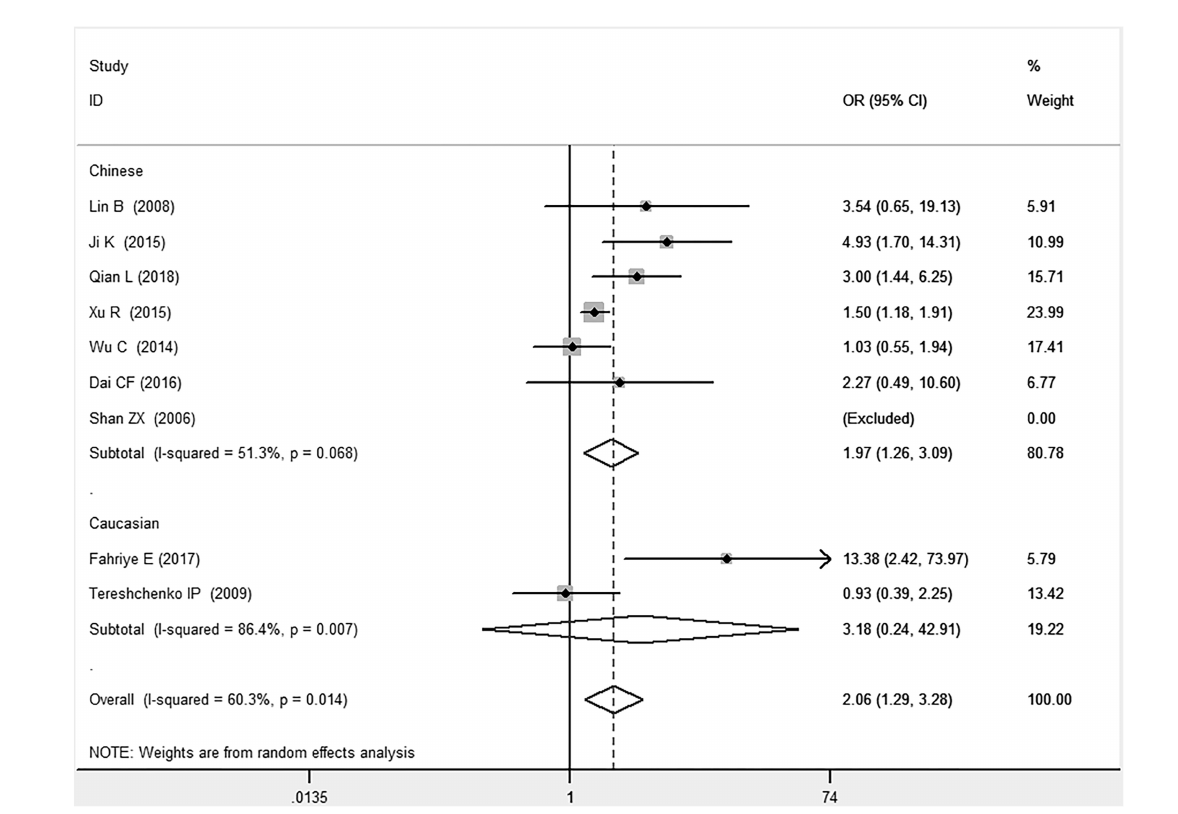
FIGURE5 Forest plot of CAD associated with MIF gene rs755622 G/C polymorphism under a homozygous genetic model (i.e., CC vs. GG of MIF gene rs755622 G/C polymorphism).